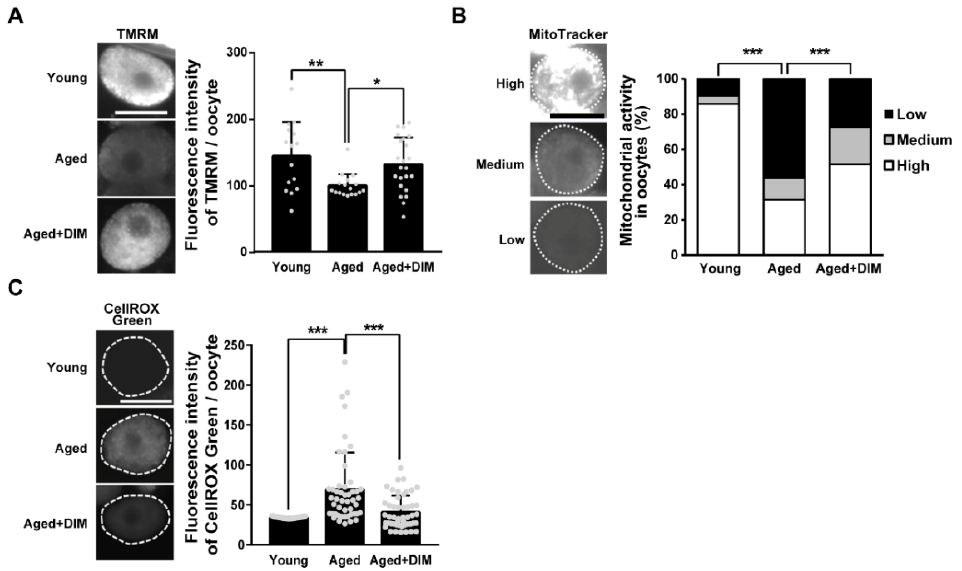
Figure 3. DIM supplementation improved the mitochondrial function in the aged Caenorhabditis elegans oocytes: ( A ) Representative images and quantification graph of mitochondrial membrane potential levels using TMRM staining were shown in the oocytes produced by day 2 adults (Young, n = 15) and day 4 adults supplemented with DMSO (Aged, n = 17) or DIM (Aged+DIM, n = 23). Error bars represent SD. *, p < 0.05, **, p < 0.01 (one-way ANOVA with Tukey’s post-hoc test). ( B ) Representative images and a percentage graph of mitochondrial activity using MitoTracker staining were shown in the oocytes produced by day 2 adults (Young, n = 42) and day 4 adults supplemented with DMSO (Aged, n = 105) or DIM (Aged+DIM, n = 95). The analysis of mitochondrial activity was classified into three categories: (1) high, (2) medium, and (3) low using the fluorescence intensity of MitoTracker dye. ***, p < 0.001 (chi-square test). ( C ) Representative images and quantification graph of mitochondrial ROS levels using CellROX Green staining were shown in the oocytes produced by day 2 adults (Young, n = 37) and day 4 adults supplemented with DMSO (Aged, n = 48) or DIM (Aged+DIM, n = 48). Error bars represent SD. ***, p < 0.001 (one-way ANOVA with Tukey’s post-hoc test). Scale bars represent 20 μ m.